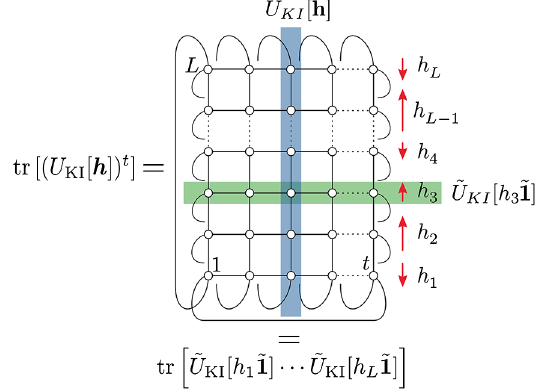
FIG. 3. Pictorial representation of the duality relation (27) fulfilled by the Floquet operator (8). Traces of powers of the Floquet operator correspond to the partition function of a classical Ising model on a t × L lattice. The column-to-column transfer h (cid:2) , while the row-to-row transfer matrix matrix is given by U KI ½ ˜ 1 ˜ U h between the ( j − 1 )th, and the j th row is given by (cid:2) . Note KI ½ j that self-duality condition implies that both transfer matrices are